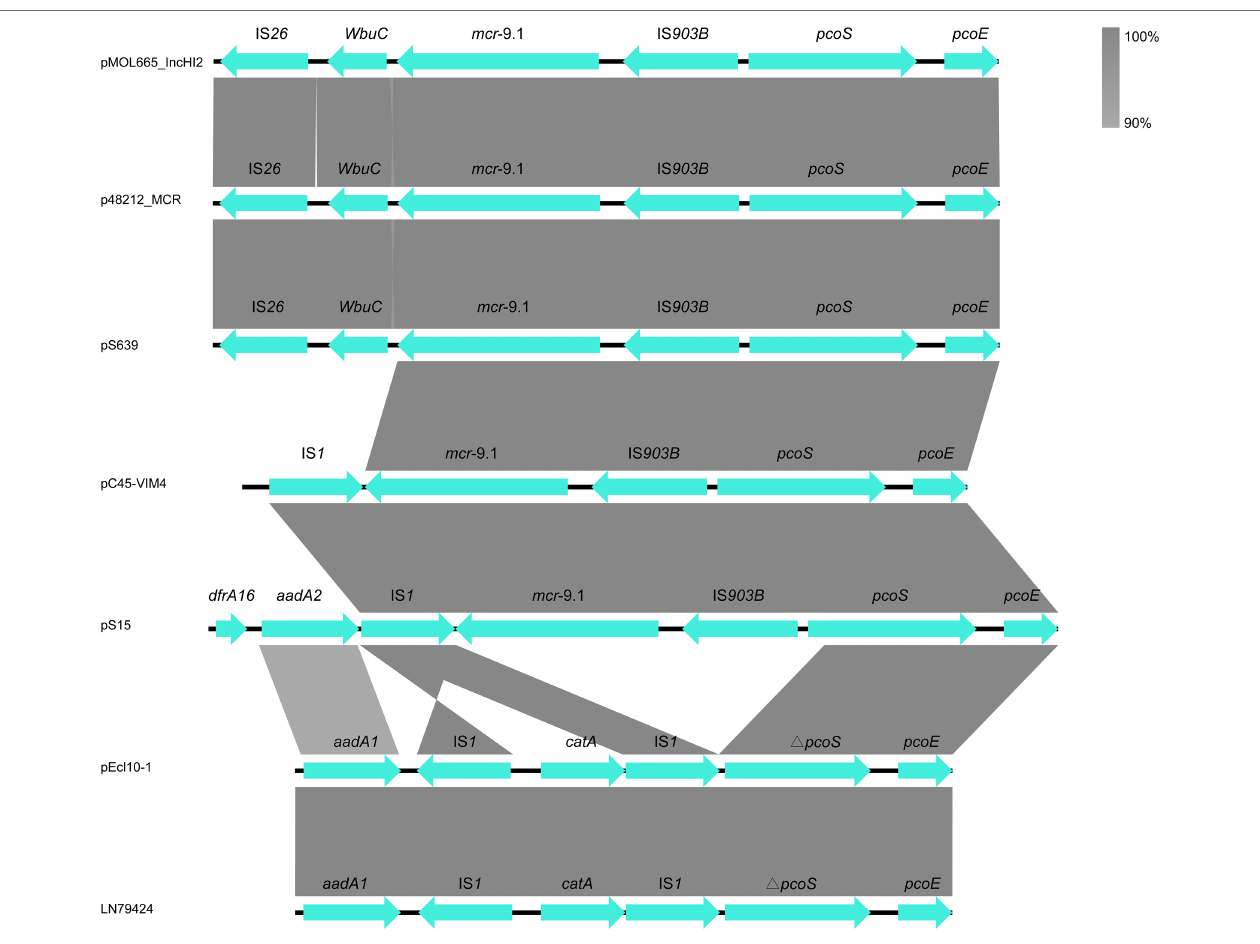
FIGURE 3 | The comparison of mcr-9 cassettes in different strains.